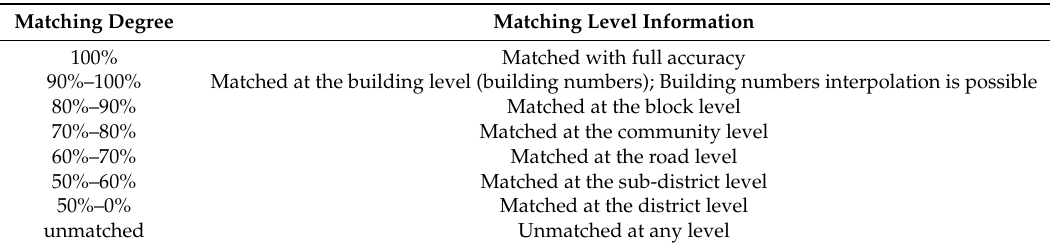
Table 2. Matching degree and its interpretation.